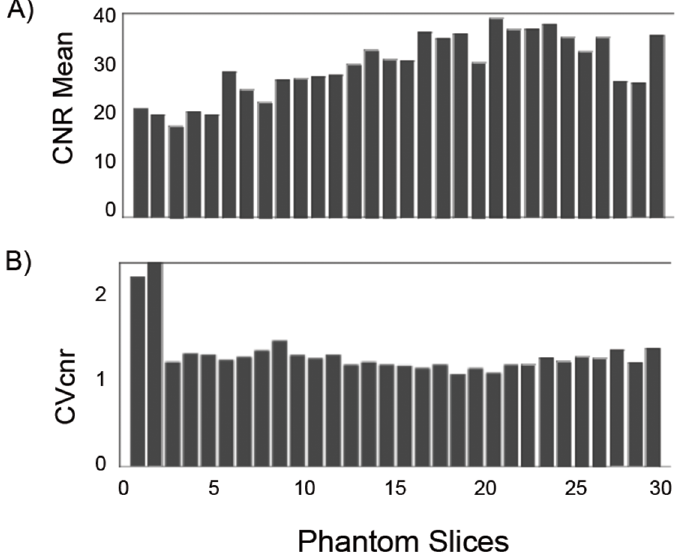
Fig 6. CNR and CV CNR dependence on slice position for GRE scan. A) CNR mean and B) CVcnr plotted across phantom slices for gradient echo scan (TR/TE/FA = 1880 ms/ 30 ms/70°, matrix = 128x128).